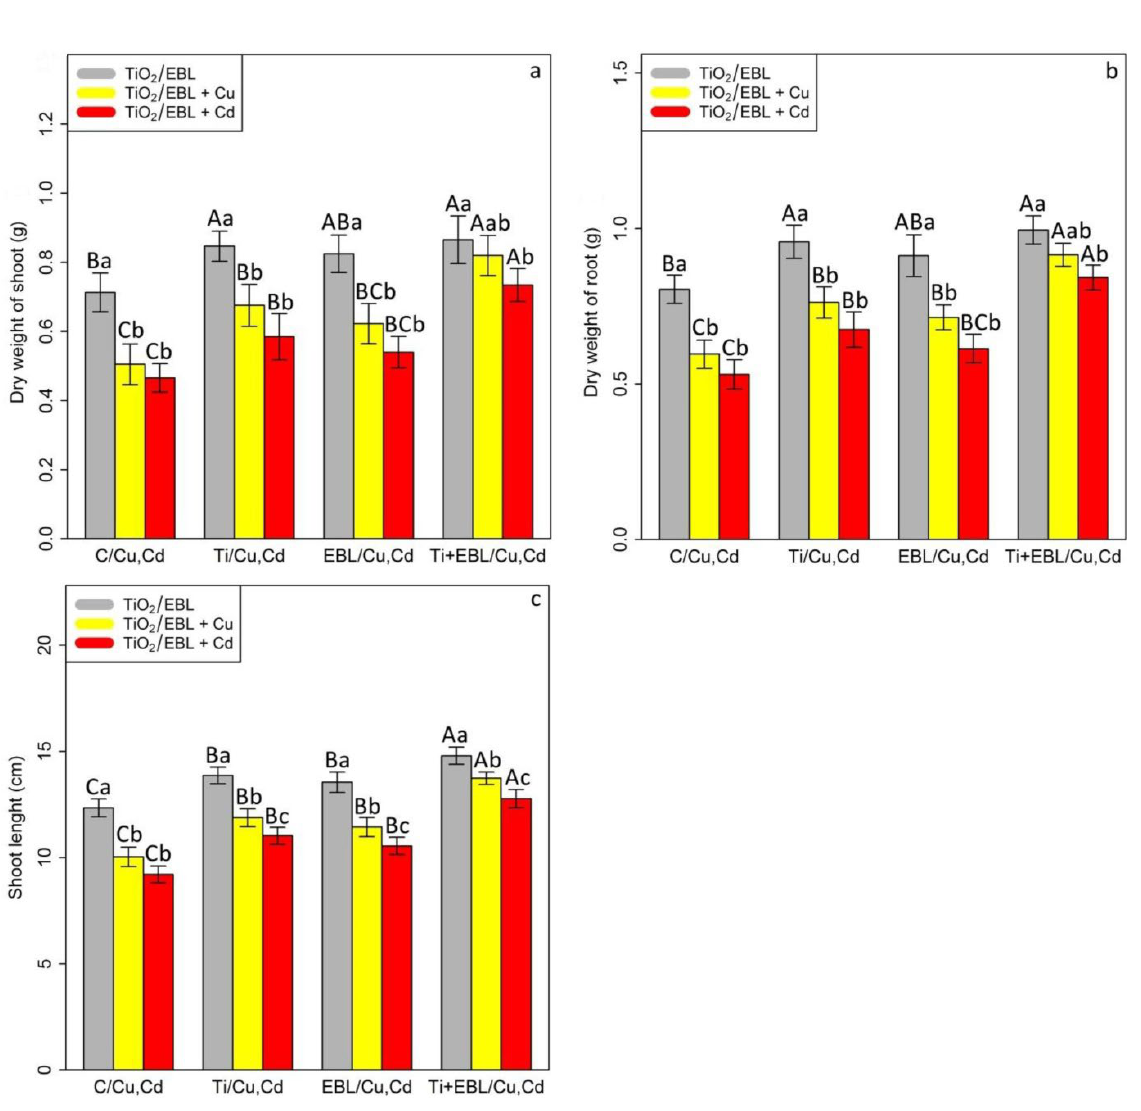
Figure 5. The impact of the co-application of 24-epibrassinolide and titanium oxide nanoparticles individually and combined on the dry weight of shoots ( a ), dry weight of roots ( b ), and shoot length ( c ) of bamboo species ( Pleioblastus pygmaeus ) with 100 µM Cu and 100 µM Cd. In this study, 1-year-old branches of P. pygmaeus were used as plant treatments together with 100 µM TiO 2 NPs and 10 −8 M 24-epibrassinolide individually and combined with 100 µM Cu and 100 µM Cd through four replications. Planting of the treated bamboo was performed in an Air Tech inoculation hood with fluorescent white lamps and ultraviolet light (wavelengths of 10–400 nm) at 15 °C and 30 °C. The bamboo plants were constantly exposed to excess heavy metals for three weeks. Sampling for the measurement of biomass indexes and plant growth ( a – c ) was conducted after three weeks of plant exposure to the co-application of 24-epibrassinolide and titanium oxide nanoparticles under 100 µM Cu and 100 µM Cd. The capital letters ( A–C ) indicate significant differences between treatments of control (C), titanium (Ti), 24-epibrassinolide (EBL), and 24-epibrassinolide involving individual or combined application of titanium oxide nanoparticles (EBL–TiO 2 NPs) under 100 µM Cu and 100 µM Cd (the bars with similar colors), while the lowercase letters ( a–c ) denote statistically significant differences at each concentration of the co-application of EBL and TiO 2 NPs individually or in combination with 100 µM Cu and 100 µM Cd (the bars with various colors) based on Tukey′s test ( p < 0.05).